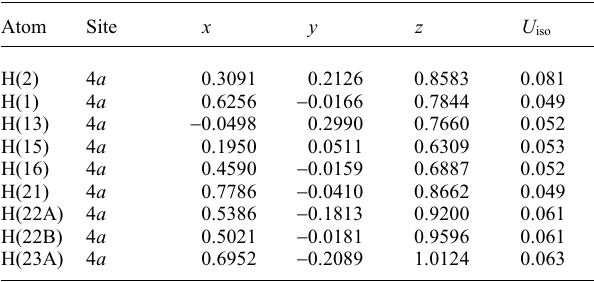
Table 2. Atomic coordinates and displacement parameters (in Å 2 )